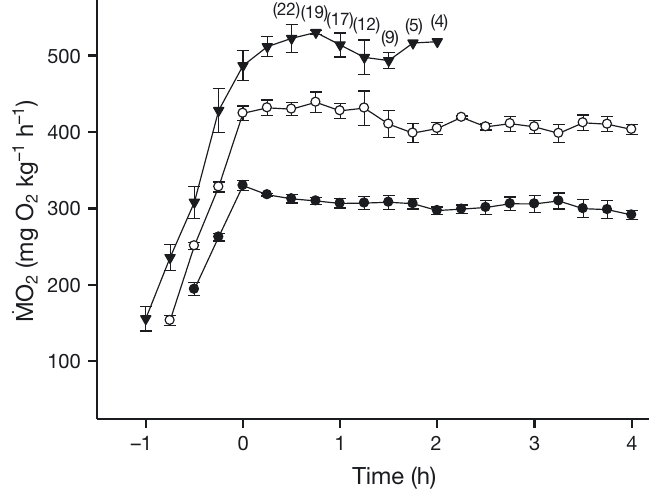
Fig. 2. Oxygen consumption rate (M˙ O 2 ) during 4 h sustained swimming trials at 60% (closed circles), 80% (open circles) and 100% (triangles) of the average critical swimming speed ( U crit ) for this batch of Atlantic salmon corresponding to 58, 78 and 97 cm s −1 respectively. Before 0 h, O 2 values correspond to the initial velocities prior to the desired swim speed being reached. Numbers in brackets: number of fish remaining; total number of fish at all other points is 24. Data are means ±